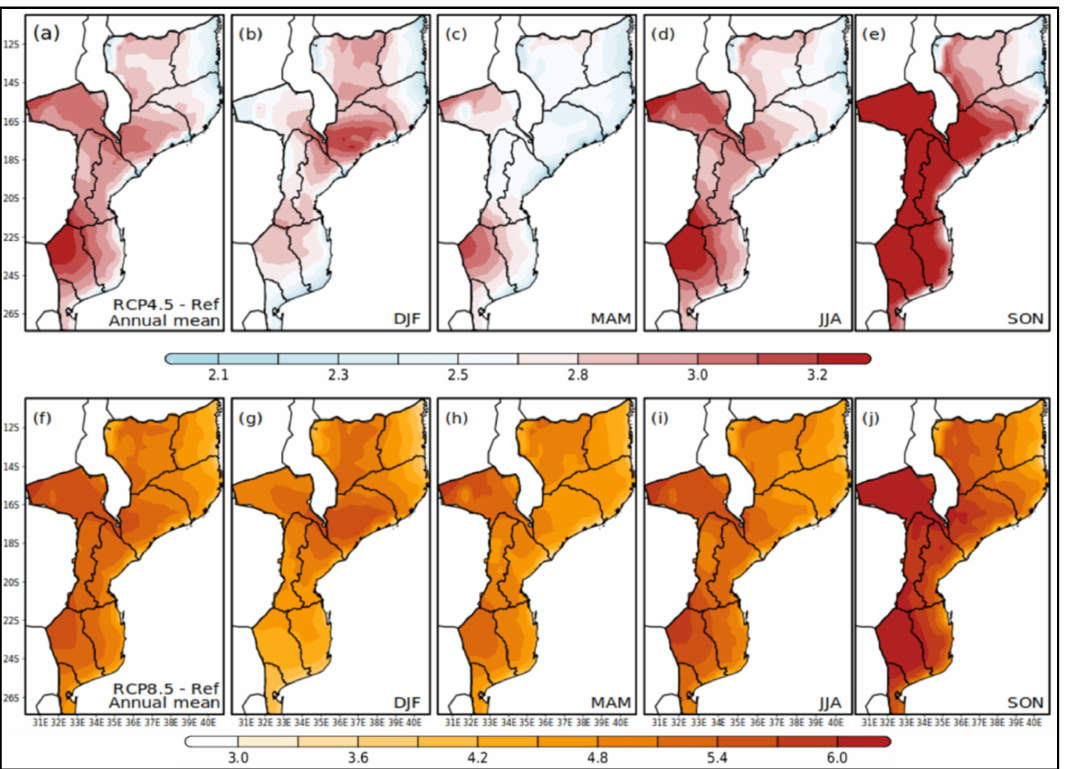
Figure 9. Signal of future climate changes in annual and seasonal mean temperature ( ◦ C), under the RCP4.5 and RCP8.5 scenarios for 2070–2099 with respect to reference period (Ref, 1971–2000), simulated by RegCM4. The first column in the panel represent the difference of annual average and each of the rest of the maps match to seasonal differences (DJF, MAM, JJA, and